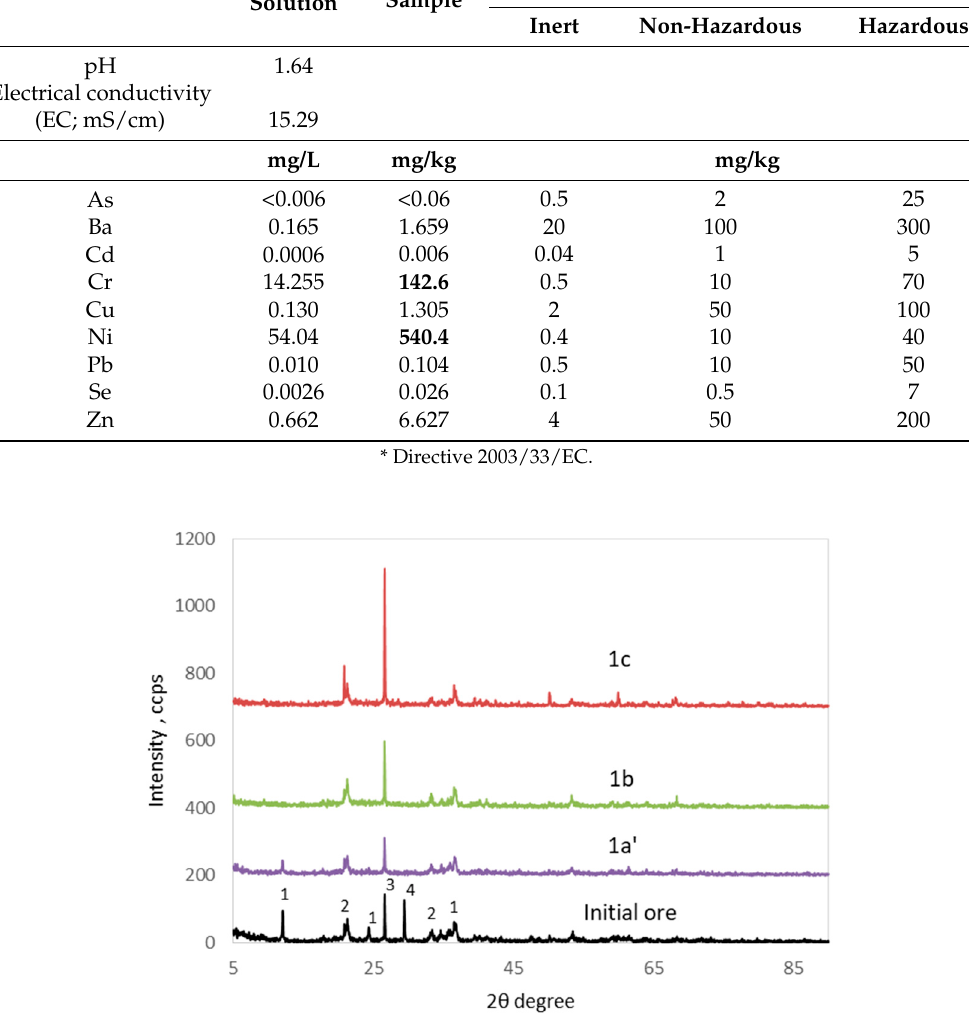
Figure 3. X-ray diffraction (XRD) patterns of leach residues from CCL in comparison with the pattern of the initial ore (1, lizardite (Mg,Al) 3 [(Si,Fe) 2 O 5 ](OH) 4 ); 2, goethite (FeOOH); 3, quartz; 4,